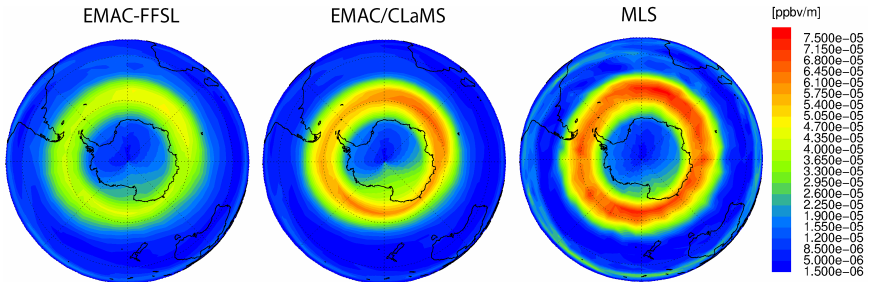
Figure 7. Horizontal gradient of N 2 O in September on the 450K isentropic surface.